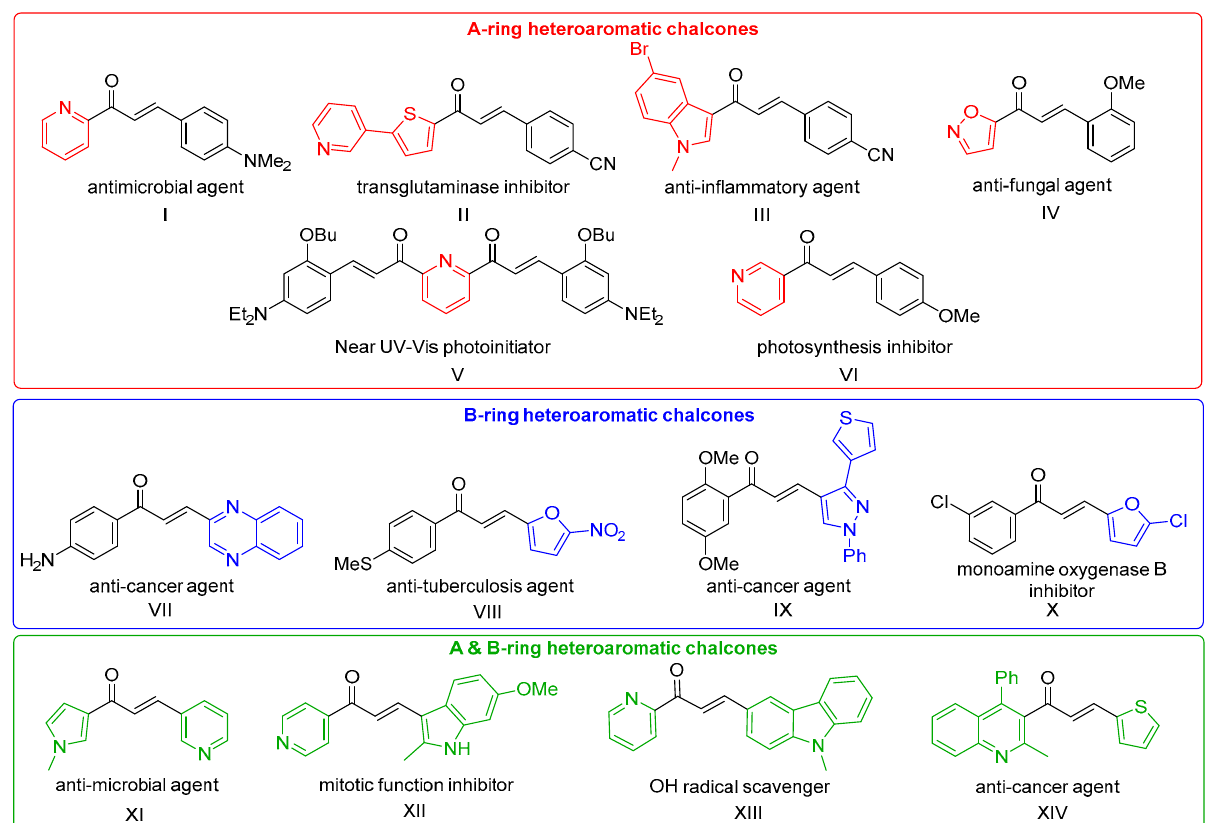
Figure 2. Medicinally and industrially important heteroaromatic hybrid chalcones.